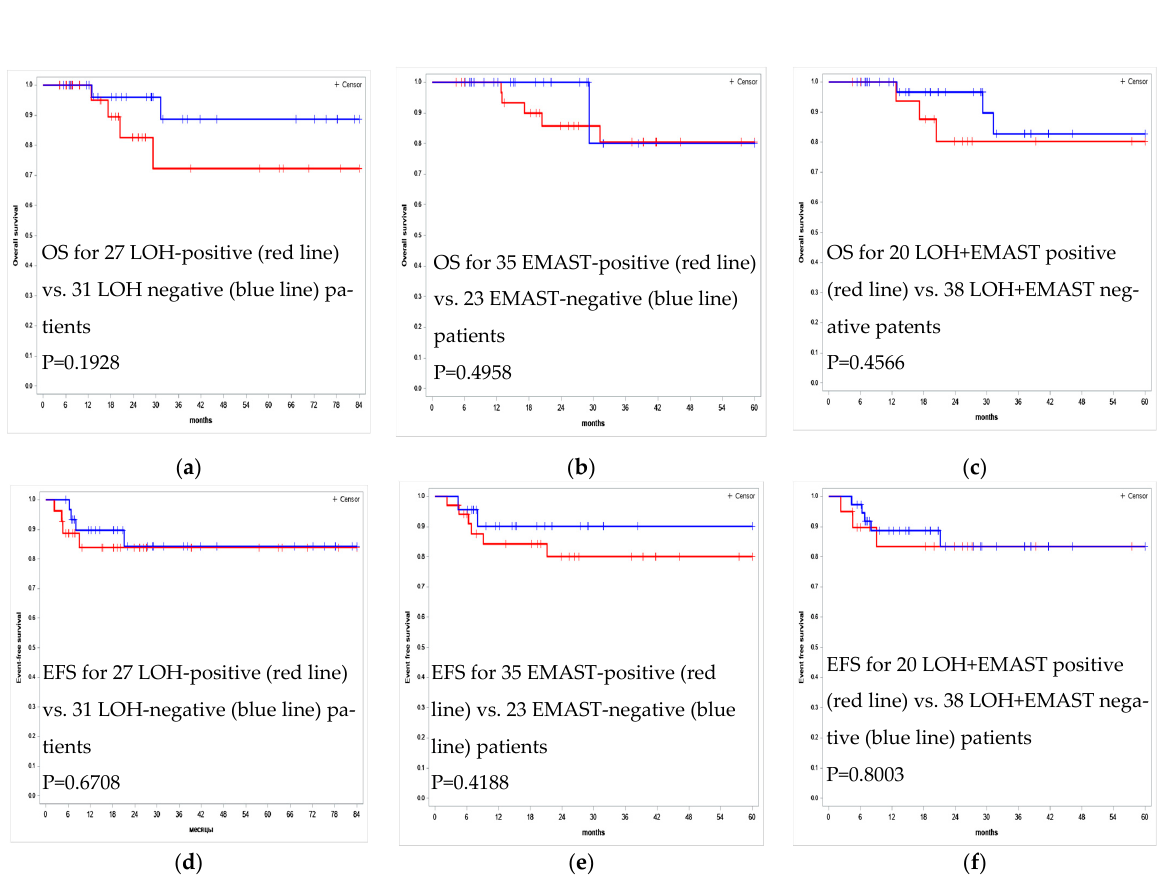
standard therapy. With a hypothetical doubling of the sample size and preserving the ratio of stable or aberrant STR profiles, in groups of patients who died or survived, an aberrant STR profile might turn out to be a significant risk factor; however it should take another two or three years to double our sample size since PMBCL is extremely rare (3– 4% of non-Hodgkin’s lymphomas).